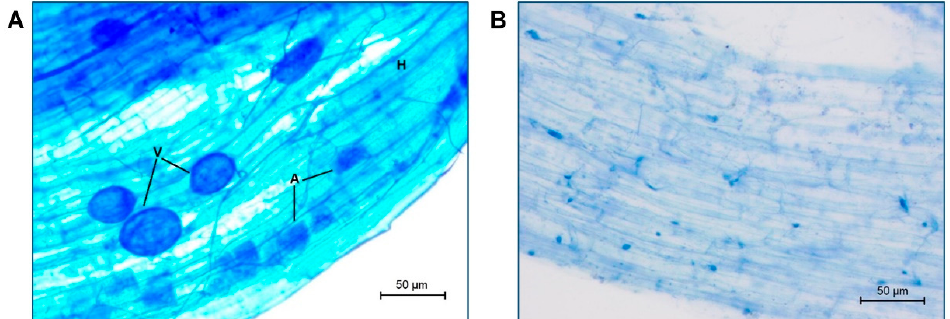
cantly increased (by 64% and 29%, respectively) in mycorrhized plants grown with MS